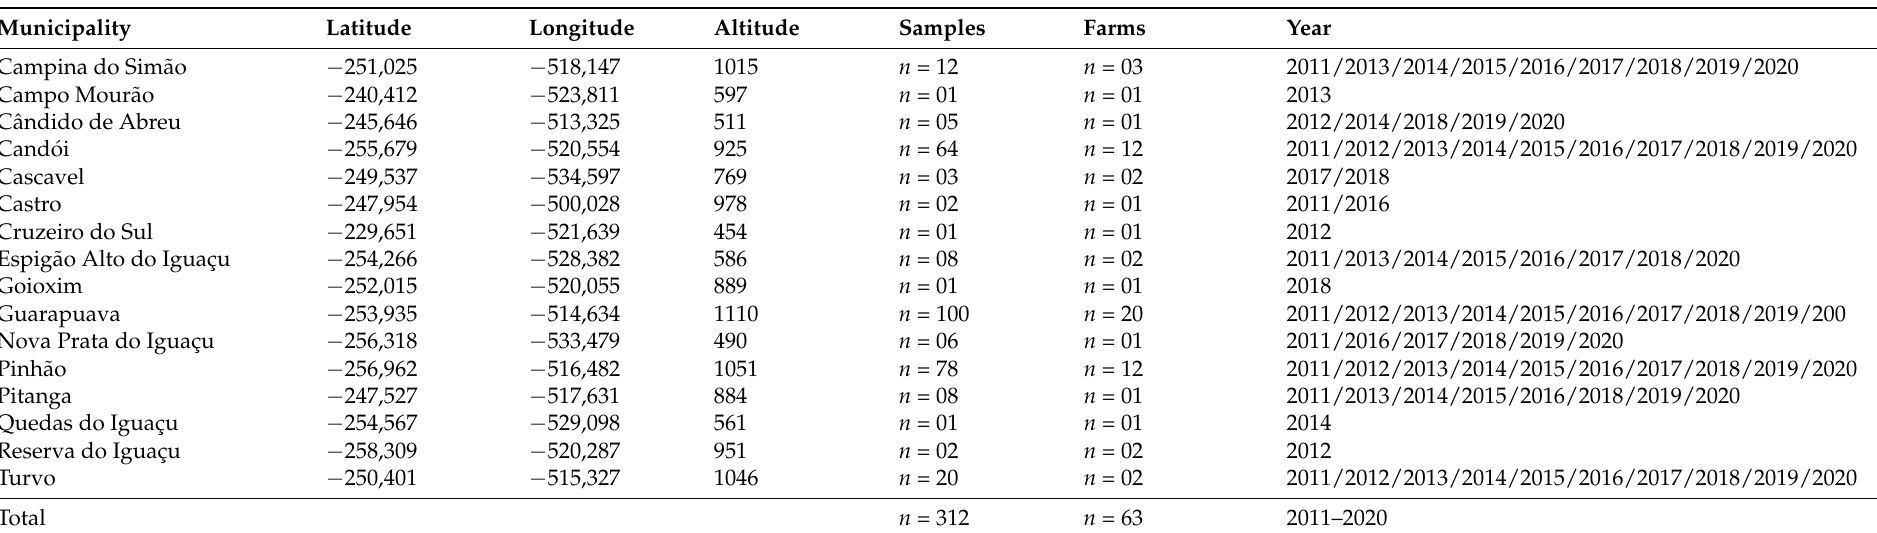
Table 1. Collection sites for whole plant samples at the time of harvesting for silage. Number ( n ) of samples and farms per site in 10 years of sampling.